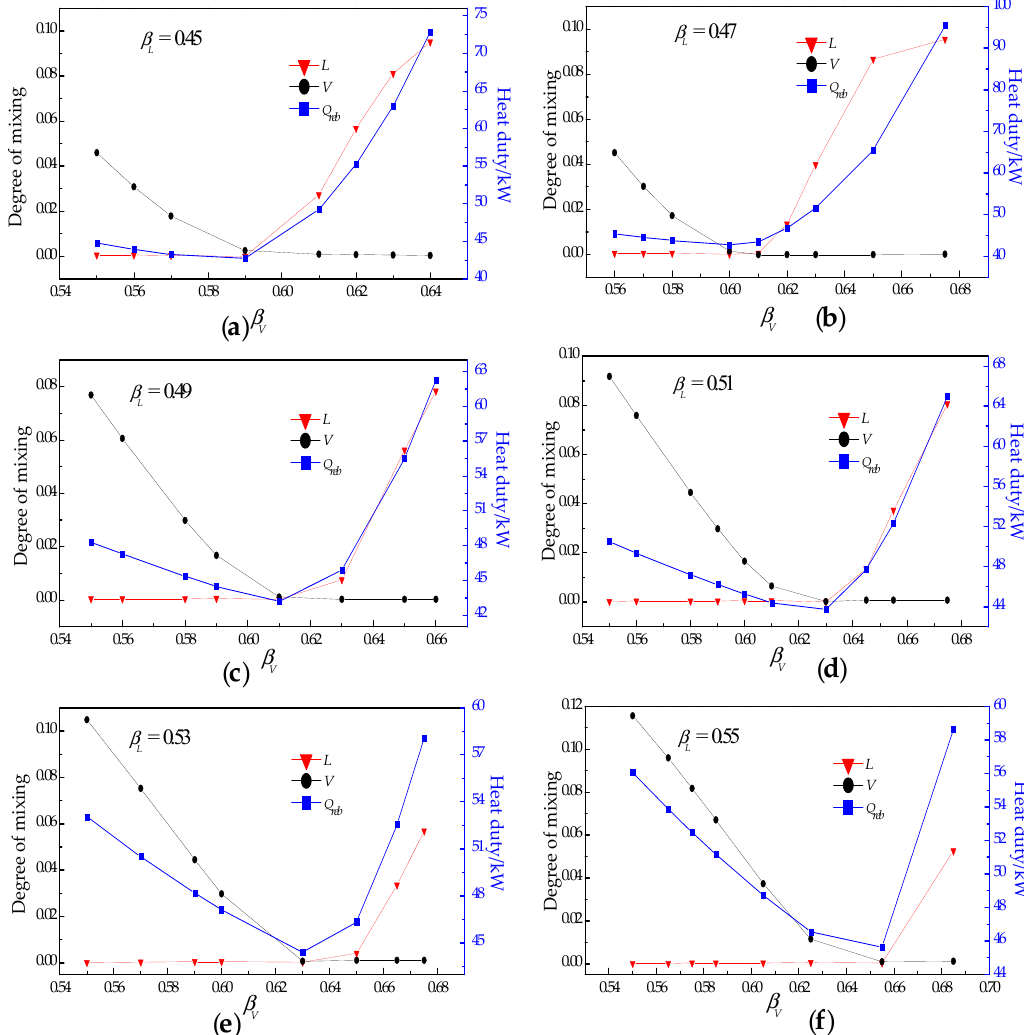
Figure 16. The effects of mixing and heat duty of reboiler versus vapor split ratio under different liquid split ratios, where L is the liquid mixing effects at the bottom of the dividing wall, V is the vapor mixing effects at the top of the wall and Q reb is the heat duty of the reboiler: ( a ) β L is fixed at 0.45; ( b ) β L is fixed at 0.47; ( c ) β L is fixed at 0.49; ( d ) β L is fixed at 0.51; ( e ) β L is fixed at 0.53; ( f ) β L is fixed at 0.55.